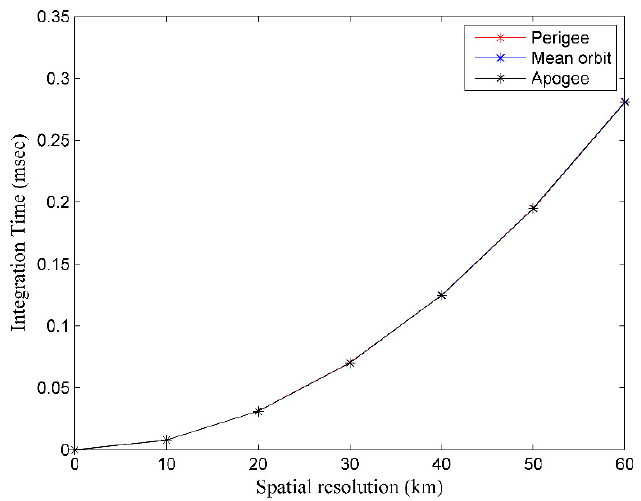
Figure 8. The change of the integration time of MBMR with spatial resolution.